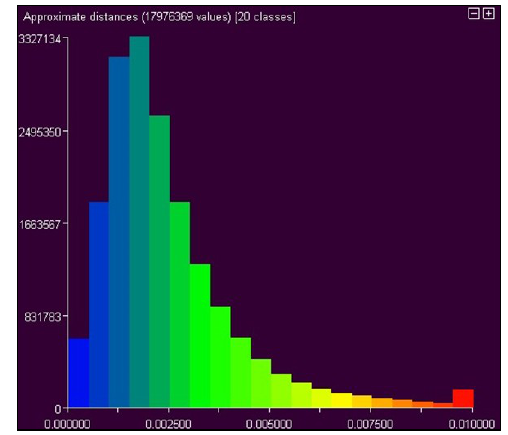
Figure 22 – Histogram detail for comparison to Max. dist.10 mm, subdivided in 20 classes (of